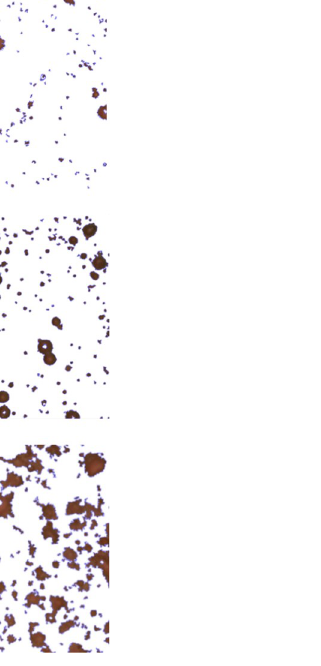
Fig 7. Particle size analysis. (a1), (b1), (c1) RTV pictures. (a2), (b2), (c2) Software analysis picture.